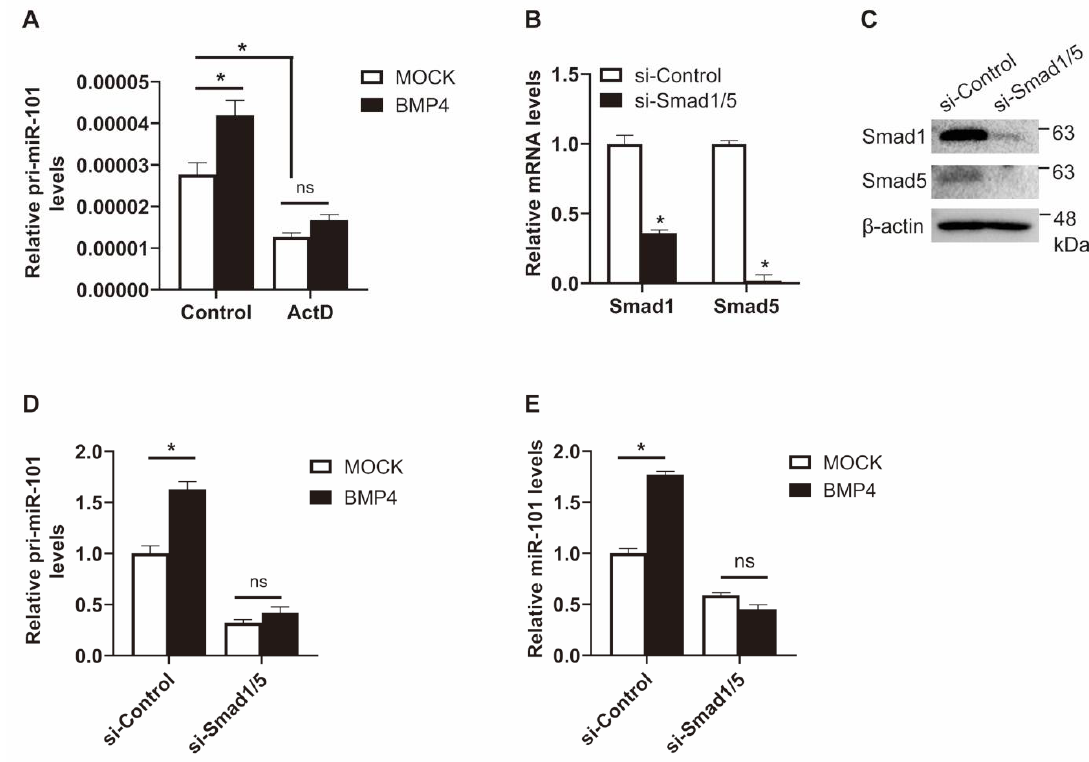
Figure 3. Smads are essential for the regulation of miR-101 expression by BMP signal. ( A ) PASMCs were treated with 25 ng/mL actinomycin D (ActD) for 2 h prior to BMP4 stimulation for 6 h. Levels of pri-miR-101 transcripts relative to 18S rRNA were measured by qRT-PCR. *, p < 0.05. ( B ) Levels of Smad1 and Smad5 relative to 18S rRNA in PASMCs transfected with si-Control or siRNAs against Smad1 and Smad5 (si-Smad1/5) were measured by qRT-PCR. *, p < 0.05. ( C ) Immunoblot analysis of lysates from PASMCs transfected with si-Control or si-Smad1/5 with anti-Smad1, anti-Smad5, or anti-β-actin antibodies. ( D , E ) PASMCs transfected with si-Control or si-Smad1/5 were treated with BMP4. The level of pri-miR-101 transcripts relative to 18S rRNA ( D ) and the level of miR-101 relative to U6 snRNA ( E ) were measured by qRT-PCR. *, p < 0.05. To elucidate the mechanisms governing Smad-dependent regulation of miR-101 expression, we mapped the miR-101 promoter region. The putative promoter region was searched through the Ensembl genome browser. Five overlapping regions of the putative miR-101 promoter were cloned into the pGL3-Basic luciferase reporter vector (Figure 4A). The generated luciferase constructs (Luc #1–#5) were transfected into COS7 cells. The luciferase activities of constructs #2, #3, and #4 were 10-, 6.3-, and 9-fold higher than that of the empty reporter vector (Vector), respectively, which implies that the region spanning construct #2 to #4 is involved in promoting miR-101 expression (Figure 4B). In addition, the luciferase activity of construct #2 was increased by BMP4 treatment, while that of the other constructs was unaffected (Figure 4C). These results suggest that the sequence of reporter construct #2 is essential for the BMP-mediated regulation of miR-101 expression.